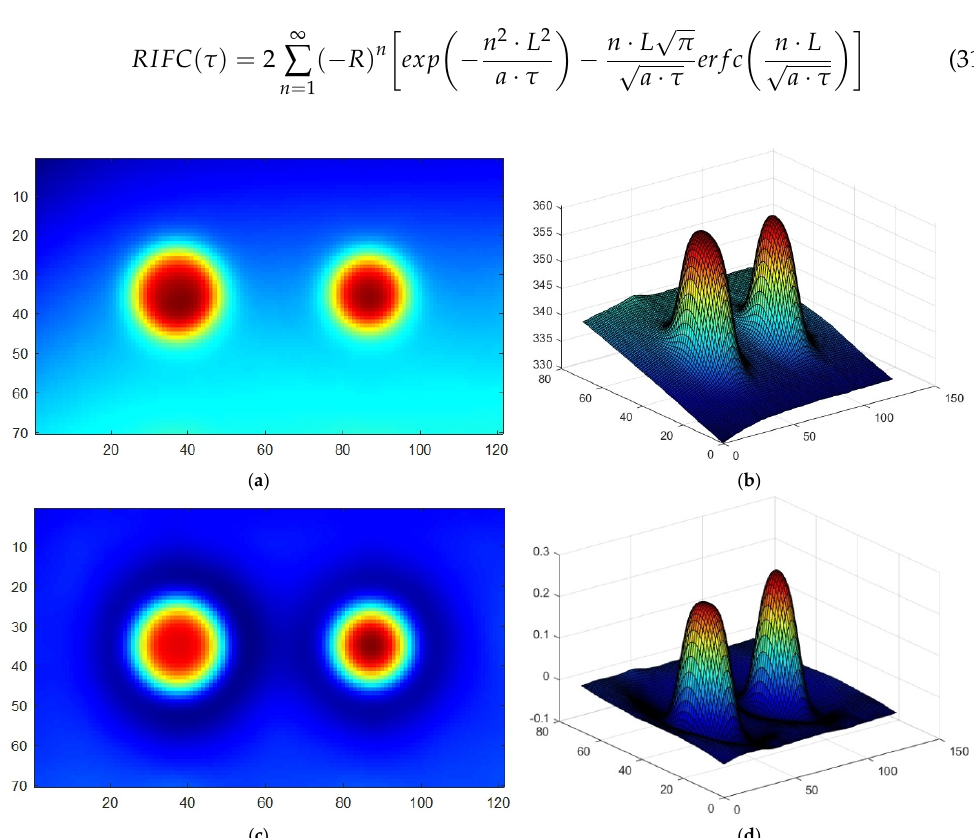
Figure 11. Example of 2D/3D thermogram no. 120 at 40 s. of heating phase: ( a , b ) measured temperature in °C, ( c , d ) processed one with relative incremental filtered contrast technique RIFC in dimensionless units.